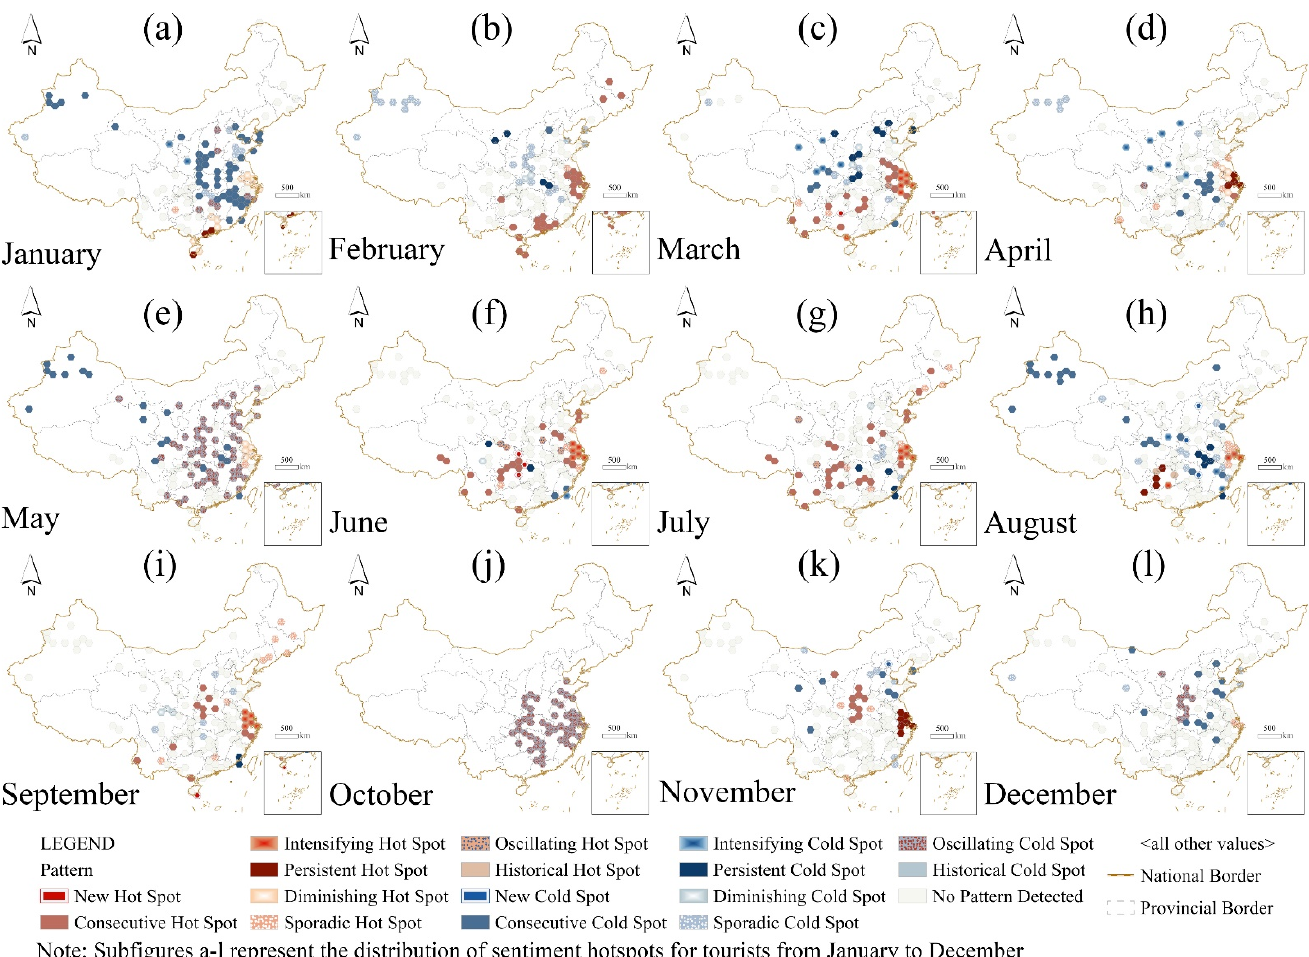
Figure 7. Distribution of monthly variations in tourists’ sentimental cold spots and hot